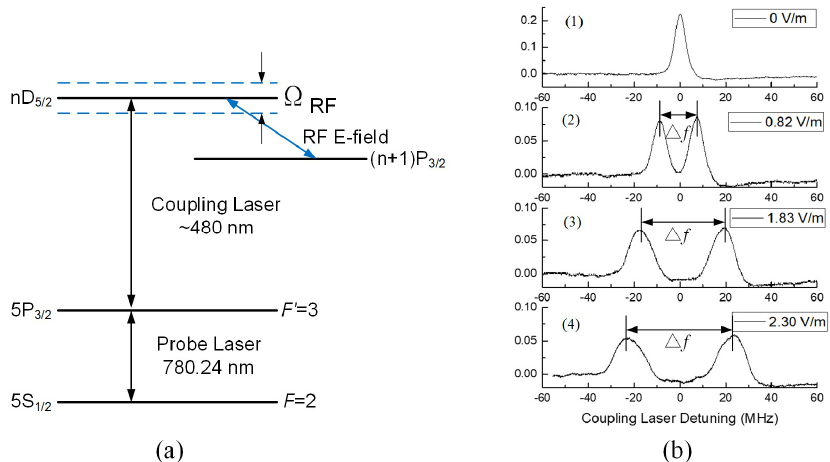
Figure 1. ( a ) Energy level of rubidium atoms involved in the radio-frequency (RF) electric field (E-field) measurement; ( b ) measured probe transmission spectroscopy at different E-field strengths as a function of the coupling laser frequency detuning.